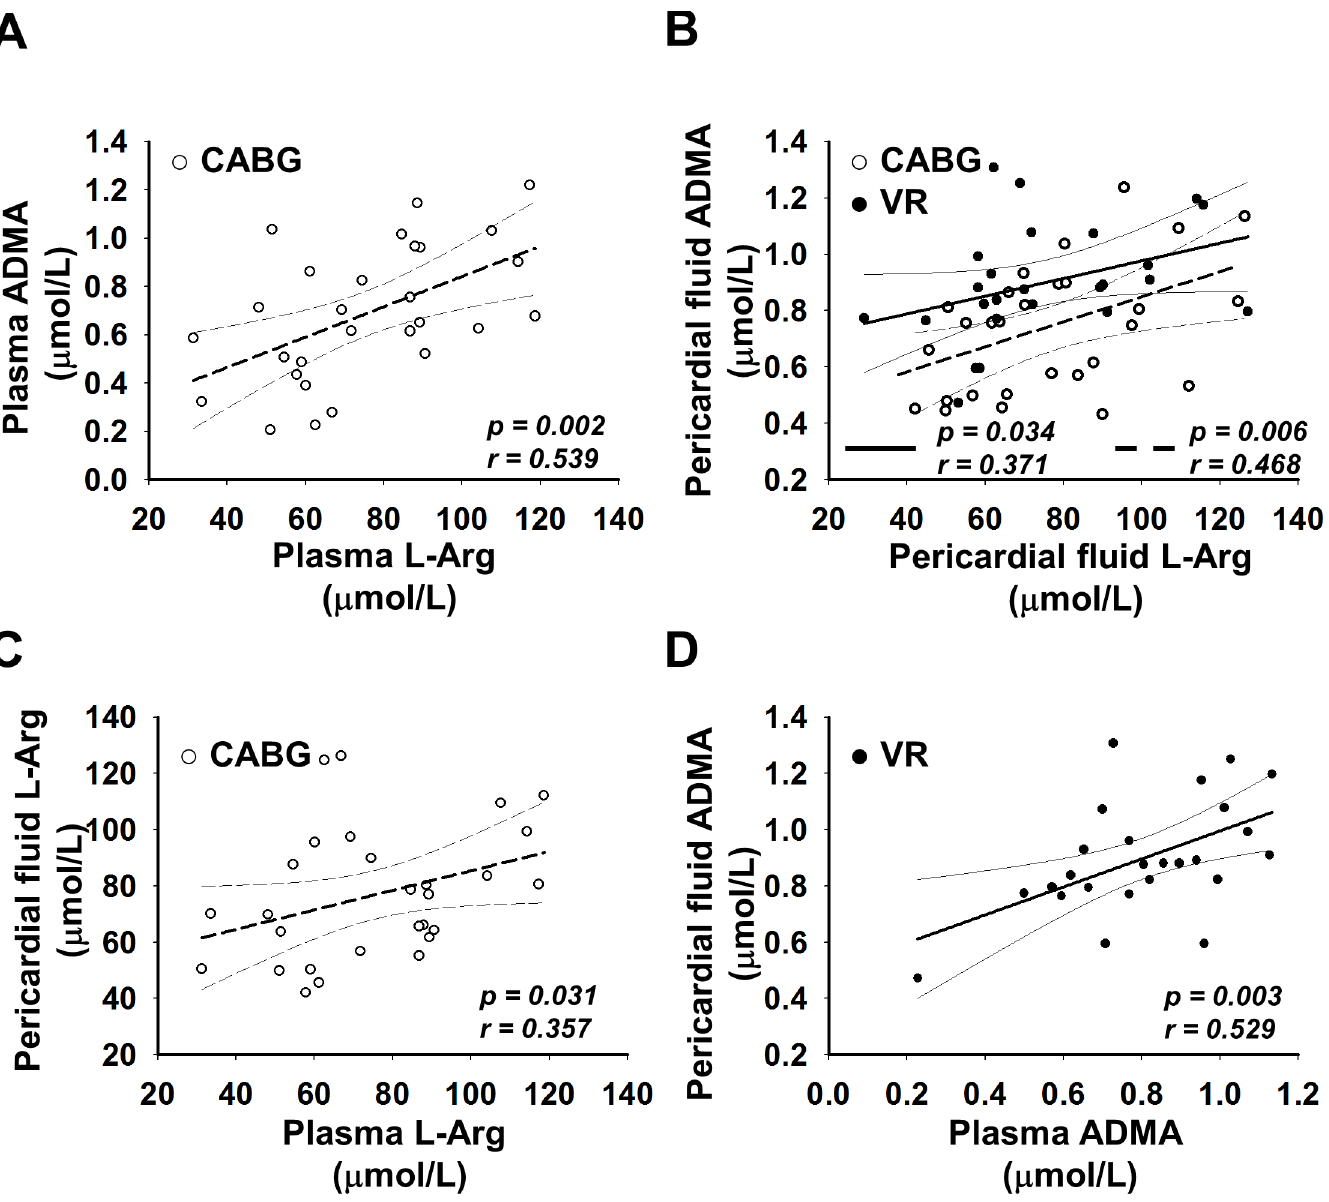
Fig 2. Correlations between the levels of L-Arg and asymmetric dimethylarginine (ADMA) in plasma and pericardial fluid (PF) of patients undergoing coronary artery bypass graft or valve replacement surgery. (A) plasma L-Arg vs. ADMA of CABG patients ( y = 0.006 x + 0.21, r = 0.539, p = 0.002); (B) PF L-Arg vs. ADMA of CABG and VR patients (CABG: y = 0.005 x + 0.39, r = 0.468, p = 0.006; VR: y = 0.003 x + 0.67, r = 0.371, p = 0.034); (C) plasma vs. PF L-Arg of CABG patients ( y = 0.347 x + 50.69, r = 0.357, p = 0.031); (D) plasma vs. PF ADMA of VR patients ( y = 0.498 x + 0.50, r = 0.529, p =